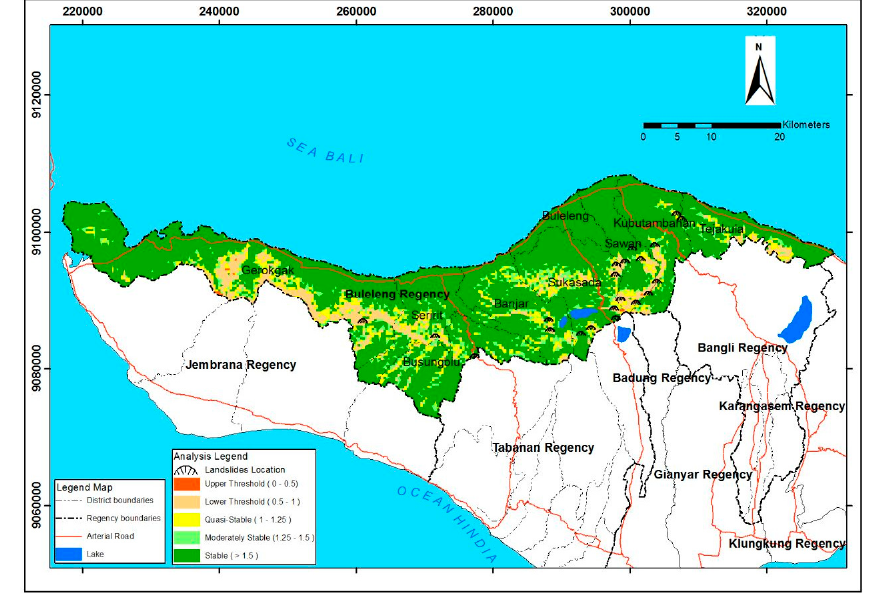
Figure 3. Hazard map of landslides using Soil Stability Index Mapping (SINMAP).